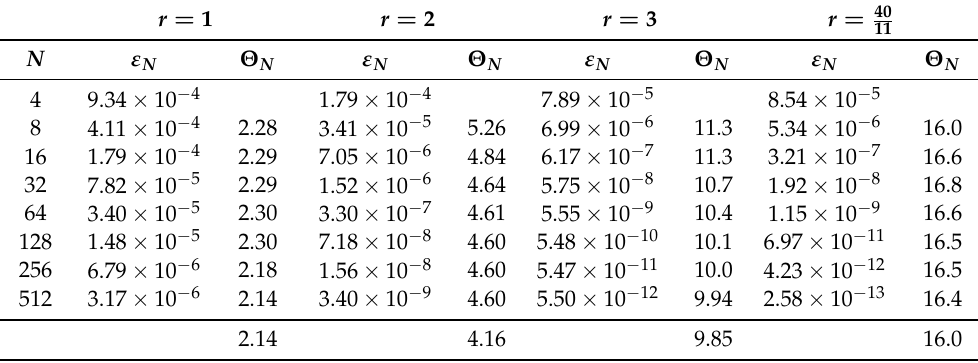
Table 5. Numerical results for problem (71) and (72) with m =